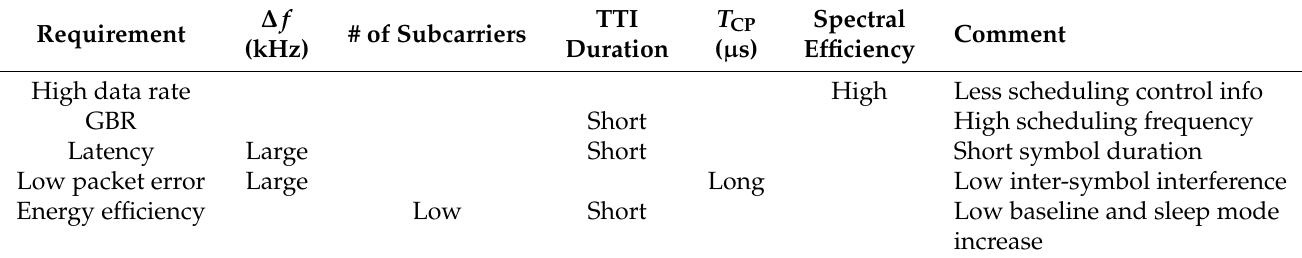
Table 5. Numerology design needs for service requirements. TTI, transmission time interval; GBR, guaranteed bit rate.